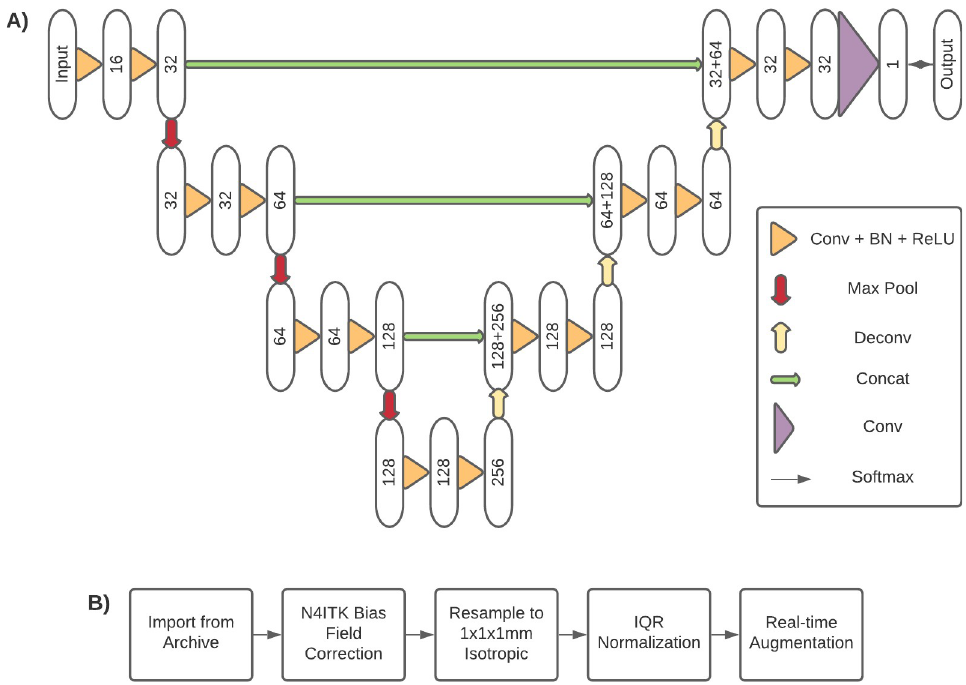
Fig 1. 3D U-Net model diagram and preprocessing steps. A) Network diagram of the 3D U-Net used for this study. Numbers within the ovals represent number of feature maps at that layer. Connections represent network operations, such as 3x3x3 3D convolution (“Conv”), 2x2x2 max pooling (“Max Pool”), 3x3x3 3D transposed convolution (“Deconv”), skip feature map concatenation (“Concat”), batch normalization (“BN”), rectified linear unit activation (“ReLU”), and softmax output (“Softmax”). B) Process diagram of preprocessing steps. Once images were imported from the archive (either PACS or challenge download), N4ITK bias field correction was applied. Images were then resampled to 1mm isotropic resolution and IQR normalized. During training, real-time augmentation was applied to each input image to create the training sample for that epoch.